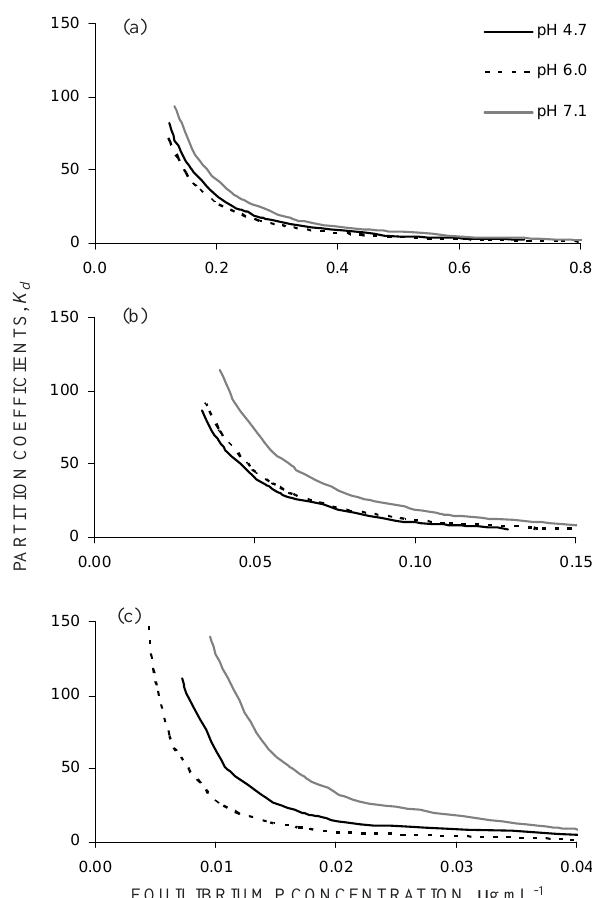
EQUILIBRIUM P CONCENTRATION, µ g mL Figure 4. Partition coefficients relative to equilibrium P concentration for P desorption isotherms at three different soil pH levels with three different initial P-addition levels. (a) 180 µg g -1 of P. (b) 80 µg g -1 of P. (c) 40 µg g -1 of P.